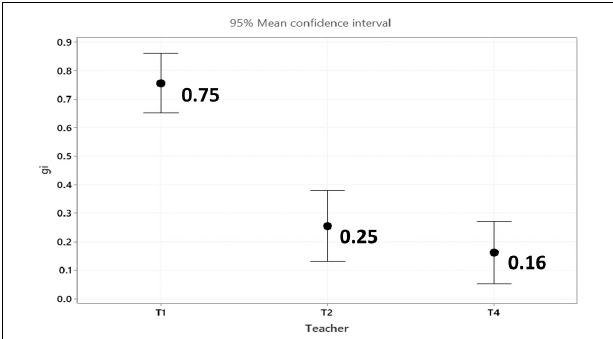
FIGURE 9 | 95% Mean confidence intervals for students relative learning gain ( gi ) second activity.